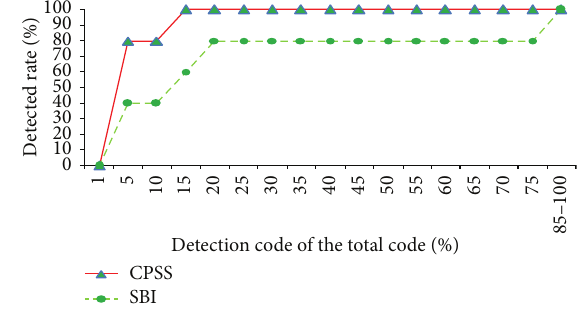
Figure 7: Location effect of the assignment